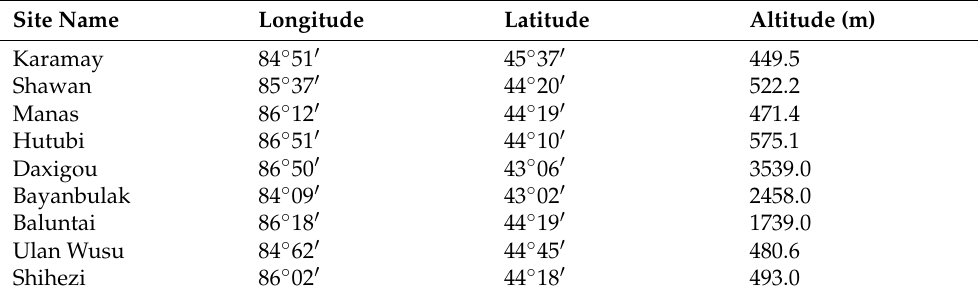
Table 1. Longitude, latitude, and altitude data of 9 monitoring stations in the study